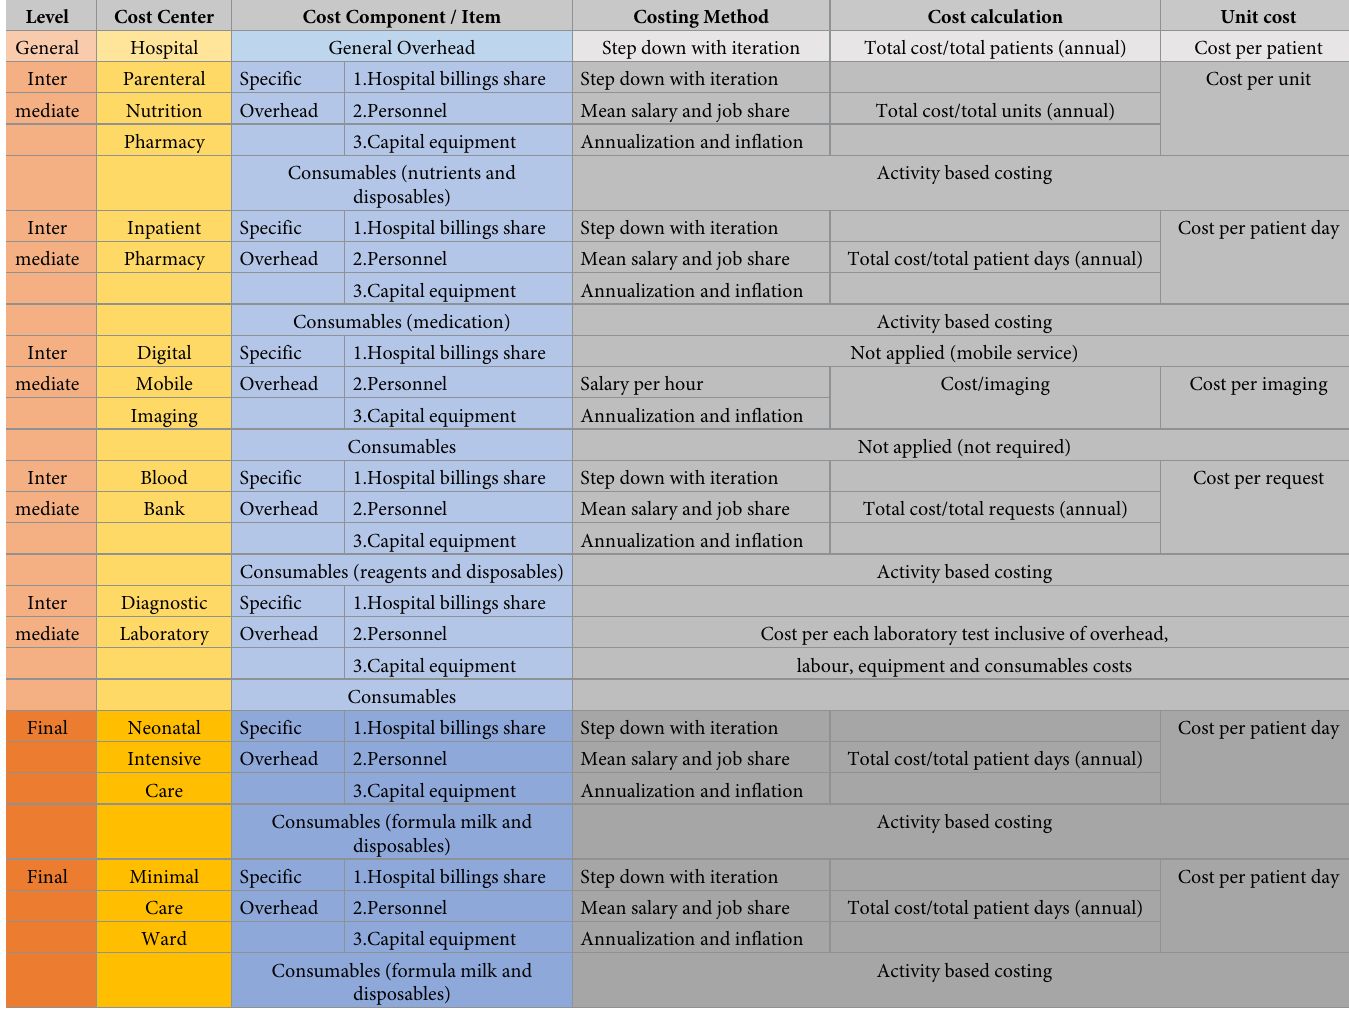
Table 1. Care provider cost analysis